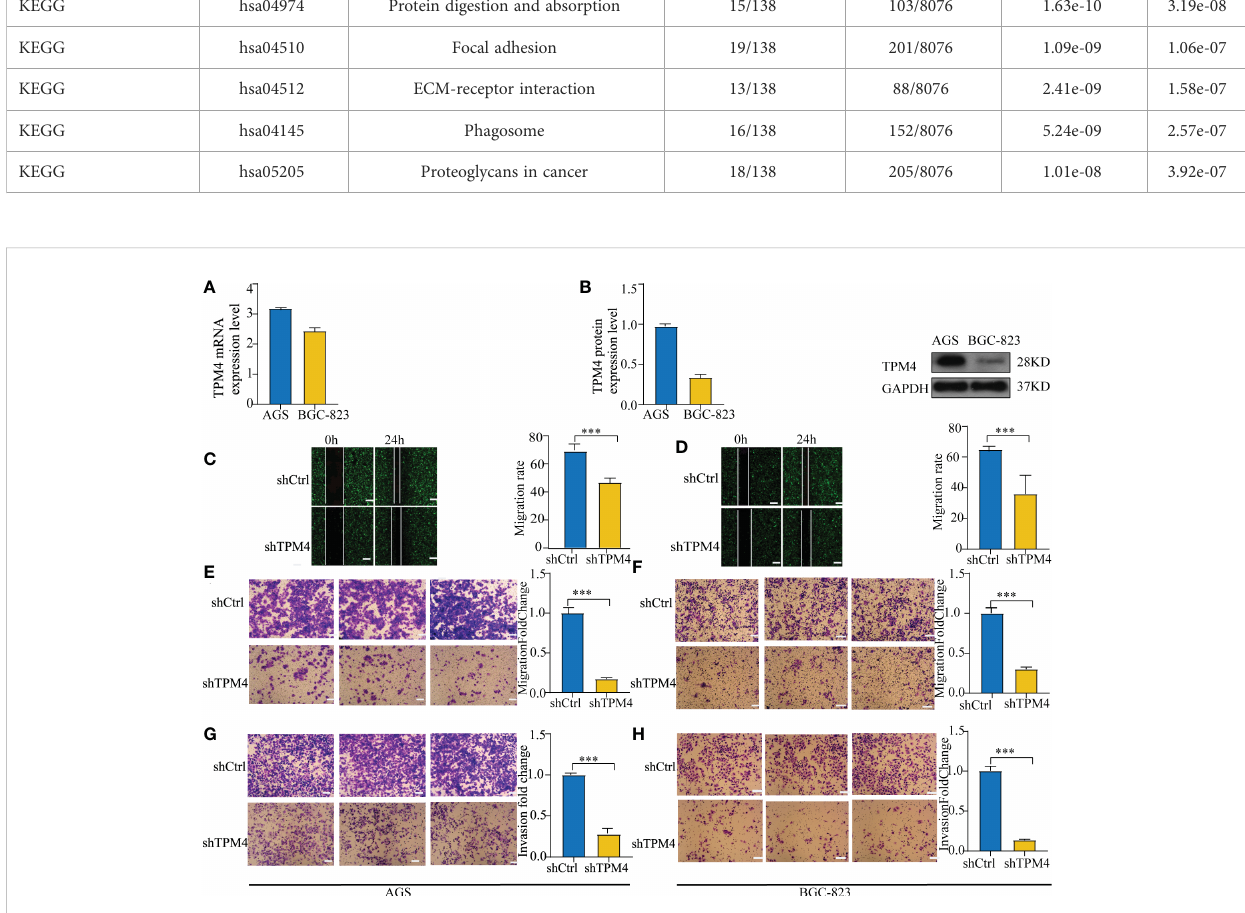
FIGURE 11 Knockdown of TPM4 inhibits migration and invasion. (A, B) . The mRNA (A) and protein expression (B) levels of TPM4 in AGS and BGC-823 cell lines. (C-F) Wound healing and transwell assays for assessing the migration potential of AGS (C, E) and BGC-823 (D, F) cells with shCtrl/shTPM4 after TPM4 knockdown. (G, H) Matrigel transwell assays were used to measure the invasive potential of AGS (G) and BGC-823 (H) cells transfected with shCtrl/shTPM4.( ***p< 0.001, compared with shCtrl.).